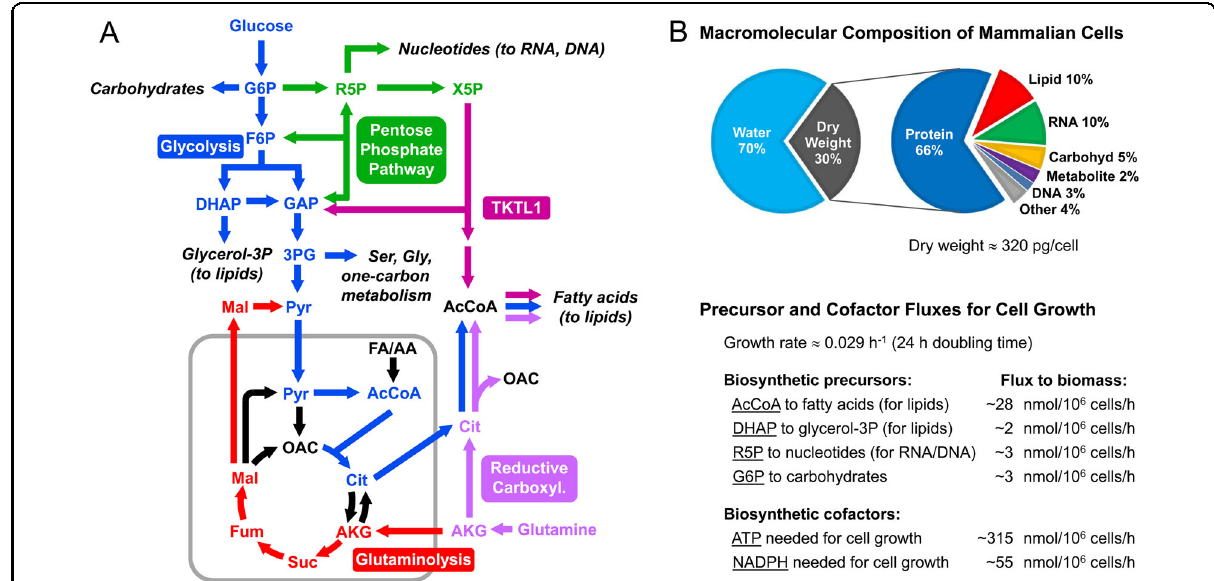
Fig. 4 13 C metabolic fl uxes are estimated based on comprehensive compartmentalized models of cellular metabolism. a The diagram shows important metabolic pathways in cancer metabolism, including glycolysis, pentose phosphate pathway, TCA cycle, reductive carboxylation of glutamine, and transketolase-like 1 (TKTL1) pathway. One of the key functions of cellular metabolism is to supply anabolic building blocks needed for cell growth, shown here as draining reactions from central metabolic pathways. b A typical macromolecular composition of cancer cells is shown. The macromolecular composition and the growth rate of cells determine the rates at which anabolic precursors must be produced to sustain cell growth. Typical values of anabolic precursor fl uxes in proliferating cancer cells are